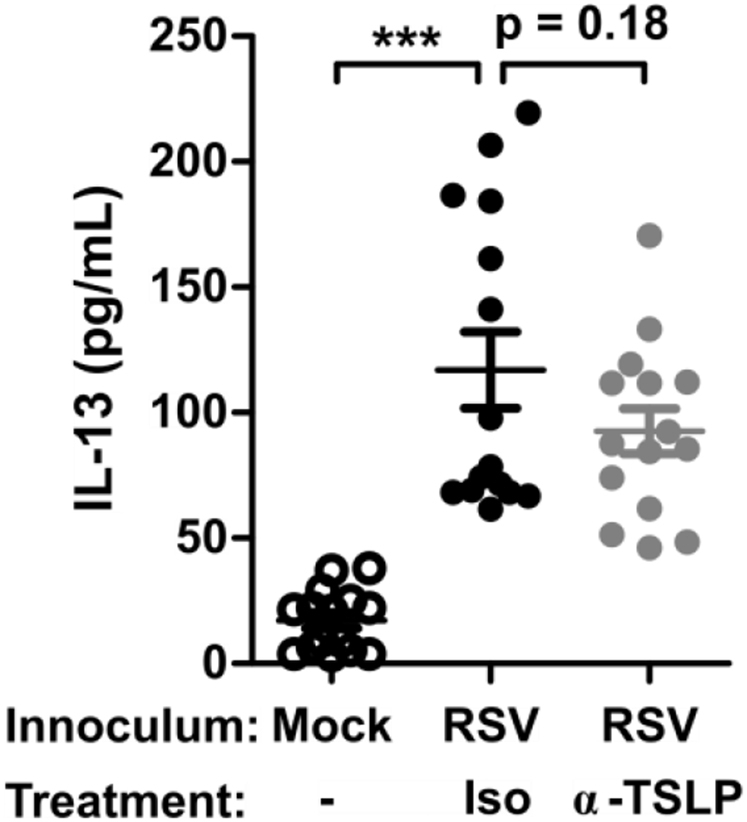
Lung IL-13 with TSLP neutralization. WT mice were infected with 3 × 106 PFU of RSV strain 01/2-20 and treated with 200 μg of anti-TSLP antibody or isotype control at 6 hours after infection, and lungs were harvested for ELISA at day 4 after infection. ELISA data are shown for measurements of IL-13 levels in the whole-lung homogenate (right and left lung). Data are plotted as means ± SEMs. For Fig E6, A, n = 15 mice per group combined from 3 independent experiments. ***P < .001, 1-way ANOVA.